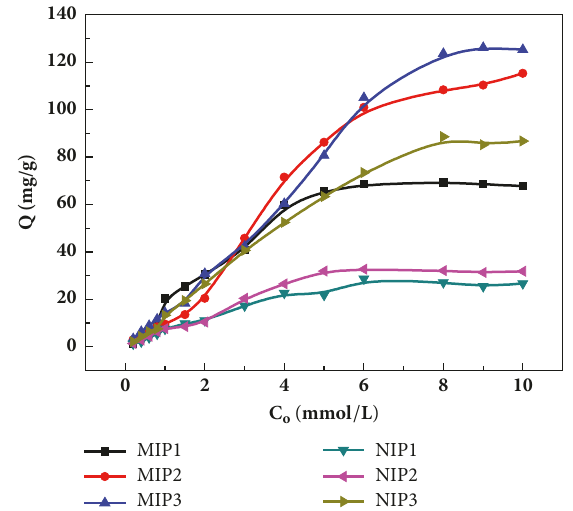
microspheres, (b) MIPs, and (c) NIPs. VBC-DVB